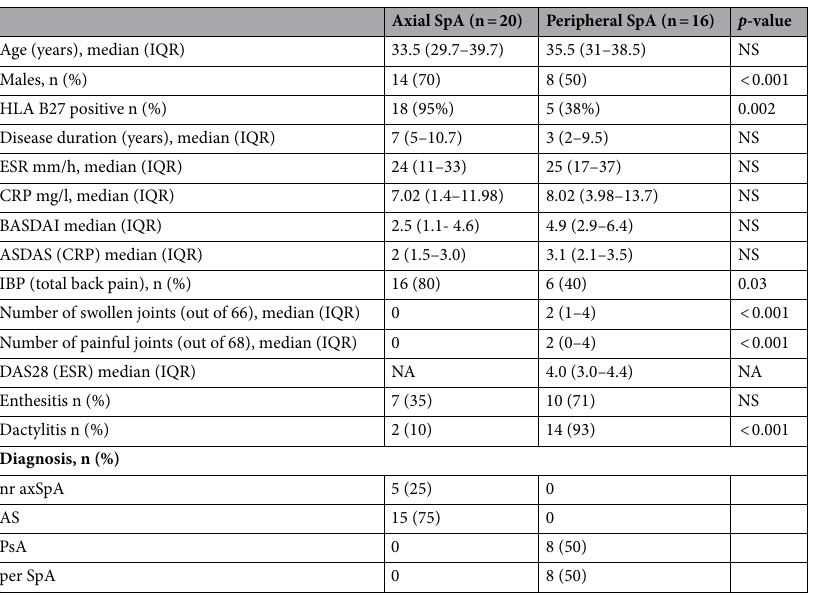
Table 1. Demographic and clinical characteristics of patient groups. BASDAI Bath Ankylosing Spondylitis Disease Activity Index; ASDAS Ankylosing Spondylitis Disease Activity Score; DAS28 Disease Activity Score (ESR) 28; IBP inflammatory back pain; CRP C-reactive protein; ESR erythrocyte sedimentation rate; ax axial; nr non radiographic; per peripheral; SpA spondyloarthritis; AS ankylosing spondylitis; PsA psoriatic